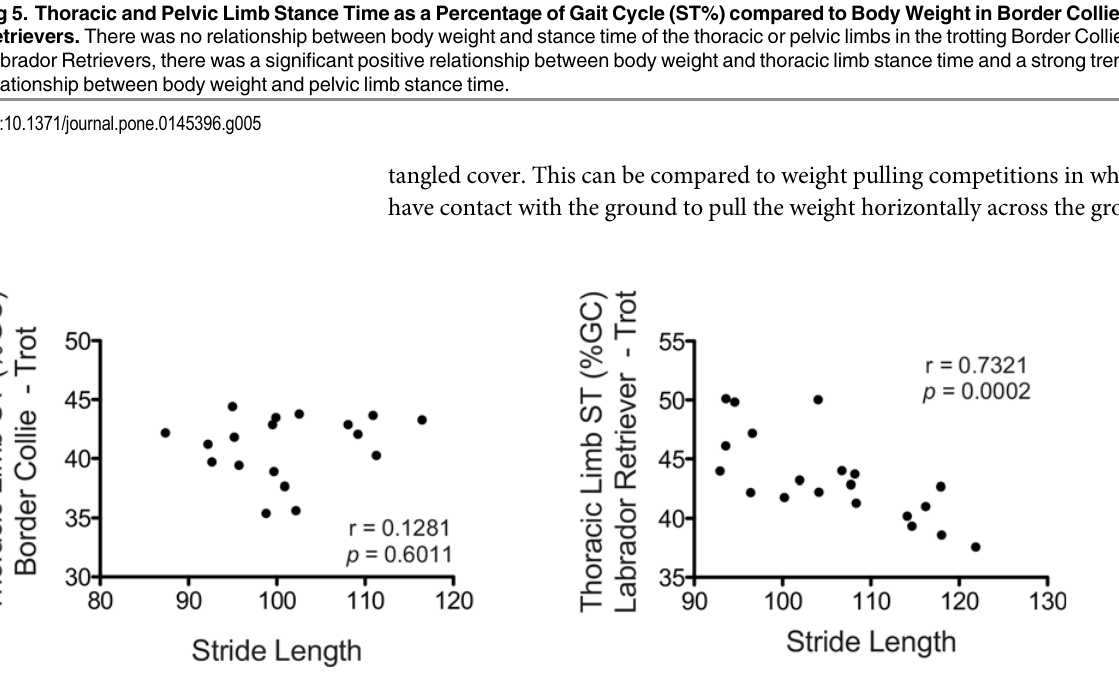
Fig 6. Thoracic Limb Stance Time as a Percentage of Gait Cycle (ST%) compared to Stride Length in Border Collies and Labrador Retrievers. As the Labrador Retrievers increased their stride lengths when trotting, they spent less time with their thoracic limbs in contact with the ground (r = 0.7321, p = 0.0002). In contrast, the amount of time spent with the thoracic limbs in contact with the ground did not change with stride length in the Border